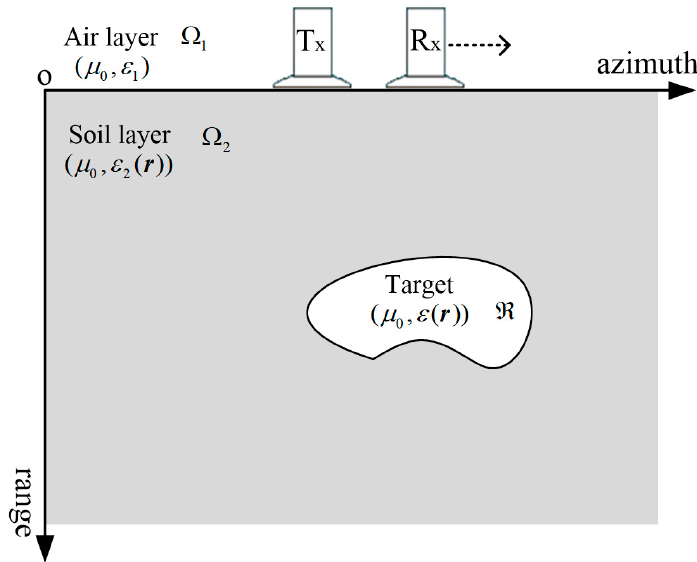
Figure 4. The geometry for a 2D problem.